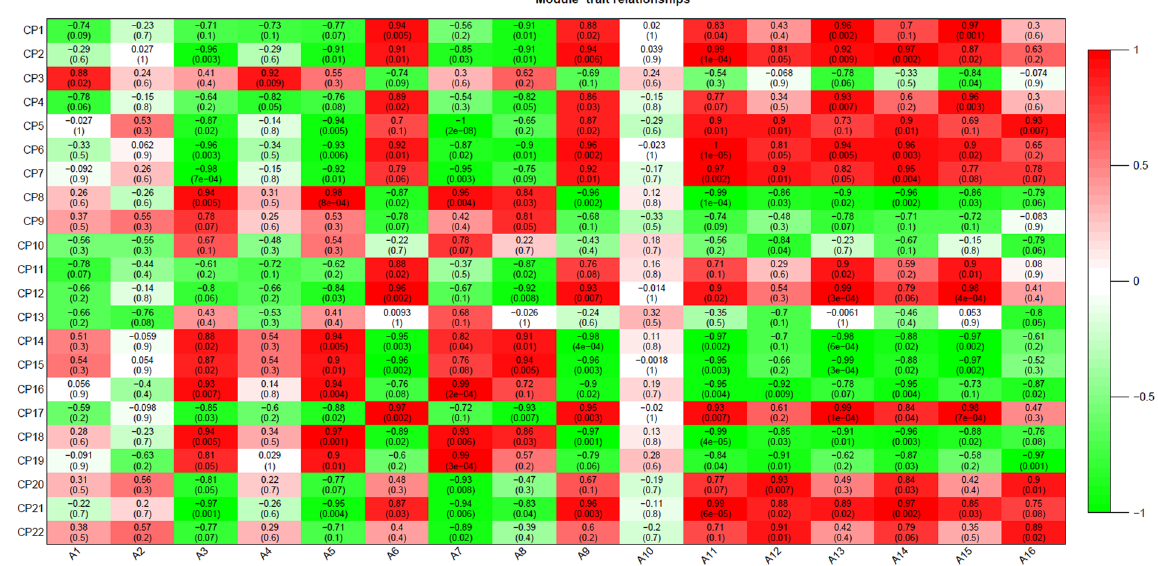
Figure 8. Correlation analysis between K -means clusters and concentration of identified flavonoids during M . trunctula MC development. Correlation between modules and flavonoid concentration is presented by colors ranging from red (highly positive correlation) to green (highly negative correlation). Columns represent the flavonoid concentration during development of MC and rows represent the modules. The correlation coefficient and p-value are shown in each cell. CP indicates the cluster number.